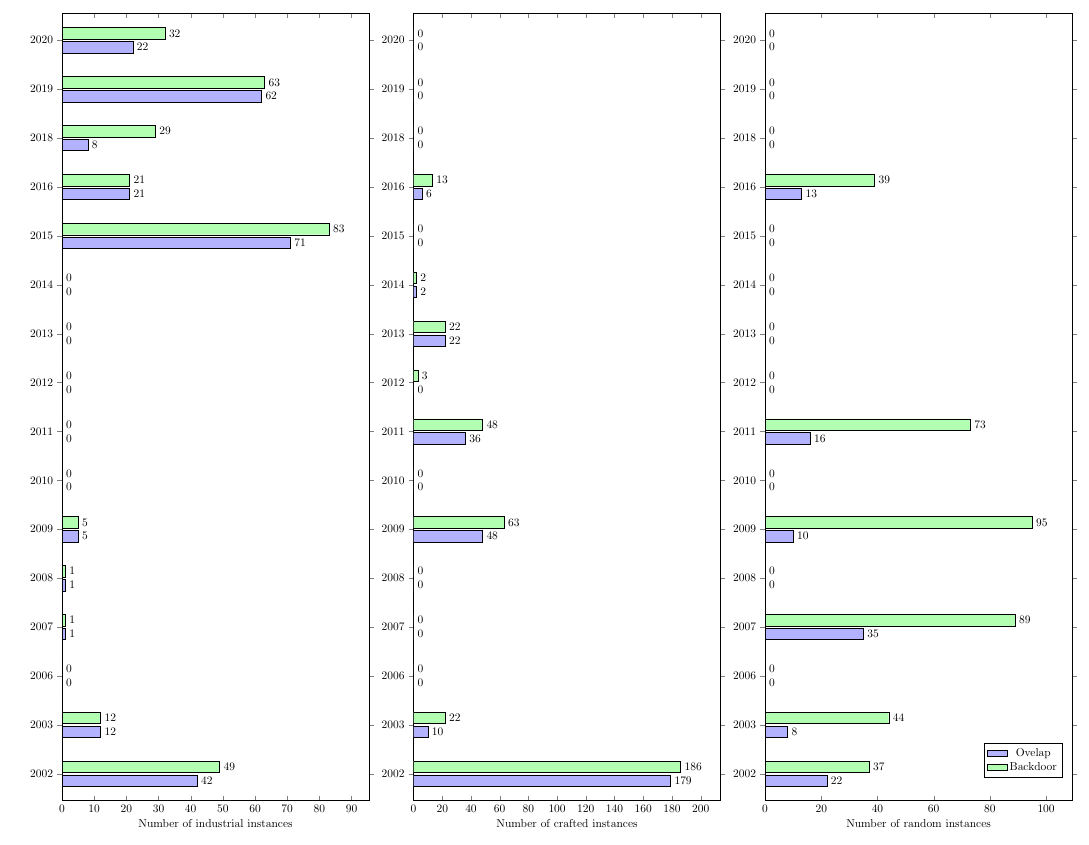
Figure A3. Number of instances with backbone/backdoor variable overlap on 2002–2020 SAT benchmark instances. Table A2. Mean (standard deviation) of the normalized values of Boolean structural measures on 2002–2020 SAT benchmark